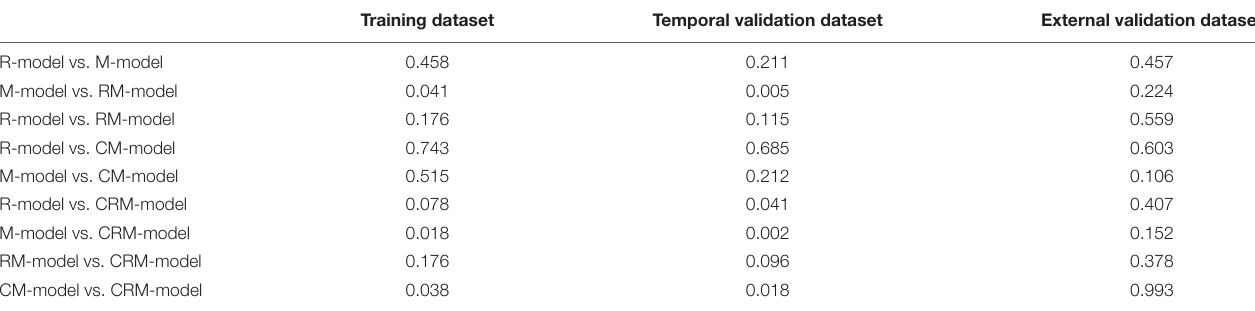
TABLE 5 | The p -values of the DeLong test of the statistical comparison of the ROC curves in all datasets.